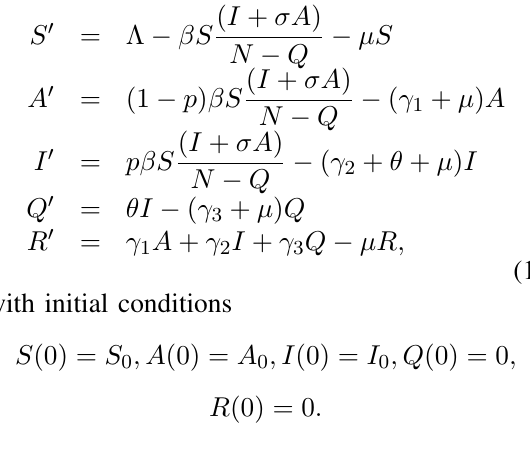
TABLE I: Definition of symbols and parameter